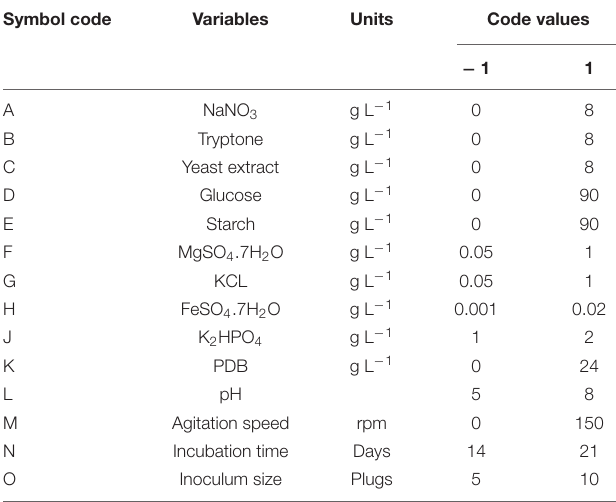
TABLE 1 | Coded and actual values of the medium used to produce cyclopiazonic acid by Penicillium commune KACC 45973 using Plackett–Burman